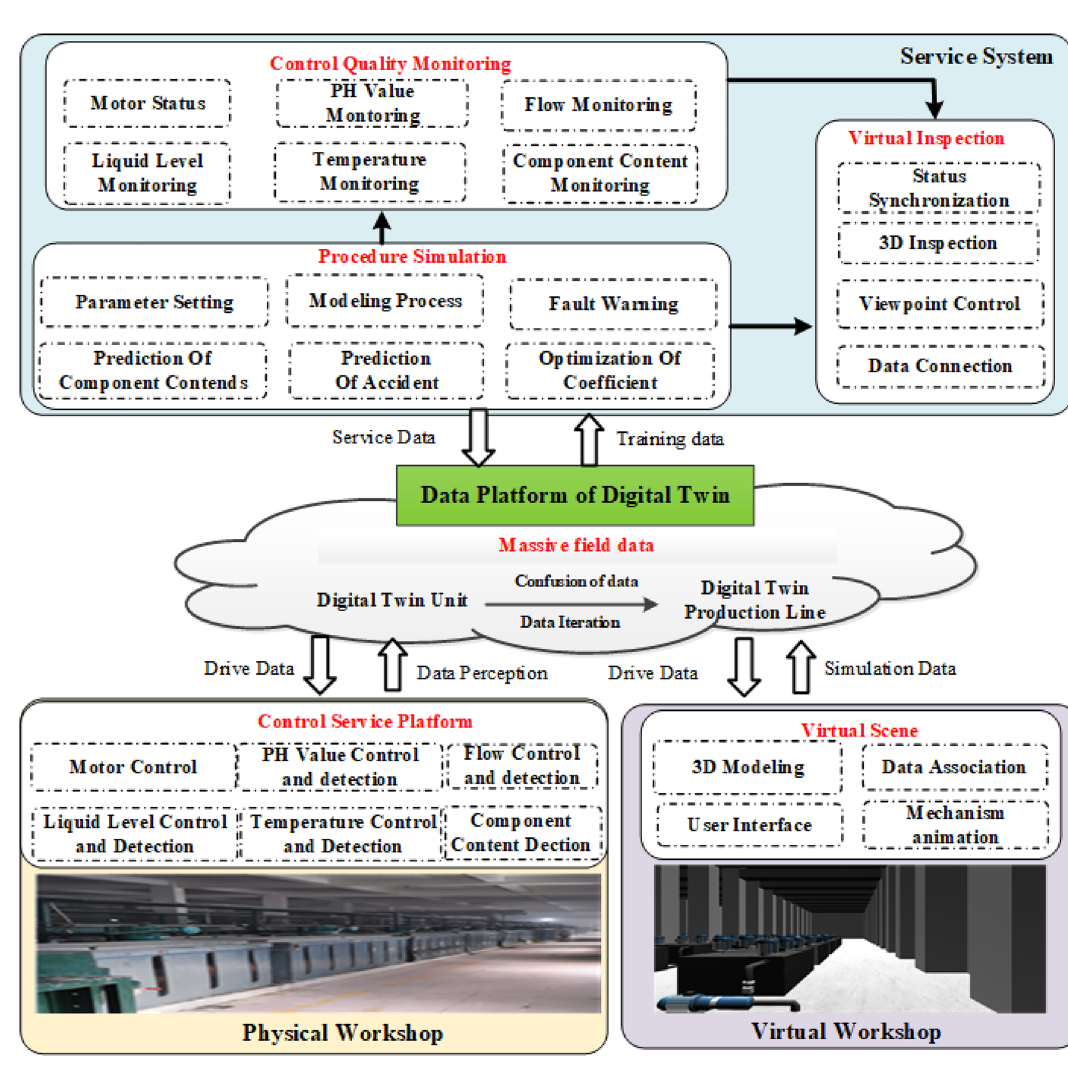
Figure 2. Basic framework of rare earth